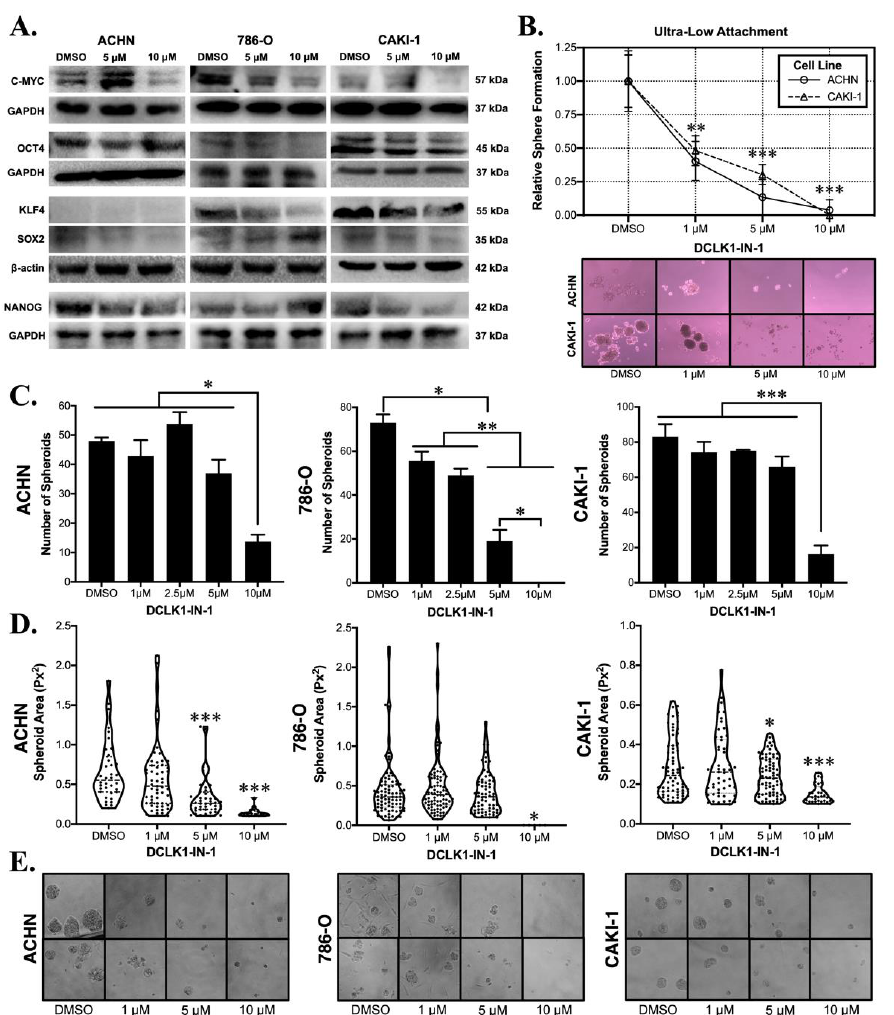
Figure 3. DCLK1-IN-1 decreases cell pluripotency factors and compromises RCC stemness. ( A ) Immunoblotting of pluripotency factors in ACHN, 786-O, and CAKI-1 RCC cells after treatment with 5 or 10 µ M DCLK1-IN-1 or DMSO vehicle control, demonstrating an overall trend towards reduced pluripotency. ( B ) Floating ultra-low attachment spheroid assay results demonstrating that DCLK1-IN-1 significantly inhibits stemness of ACHN and CAKI-1 RCC cells at 1, 5, and 10 µ M concentrations (** p < 0.01, *** p < 0.001 vs. DMSO; microscope images: 10 × magnification). ( C ) Matrigel spheroid assay results for ACHN, 786-O, and CAKI-1 RCC cell lines, demonstrating a potent anti-stemness effect at 10 µ M resulting in an approximately 70% mean decrease in the number of spheroids (* p < 0.05, ** p < 0.01, and *** p < 0.001). ( D ) Image-based quantification of spheroid area showing that DCLK1-IN-1 treatment significantly limits the size of the spheroids that do manage to form after treatment (* p < 0.05, *** p < 0.001 vs. DMSO). ( E ) Representative images from Matrigel spheroid assays quantified in ( C , D ) (20 ×